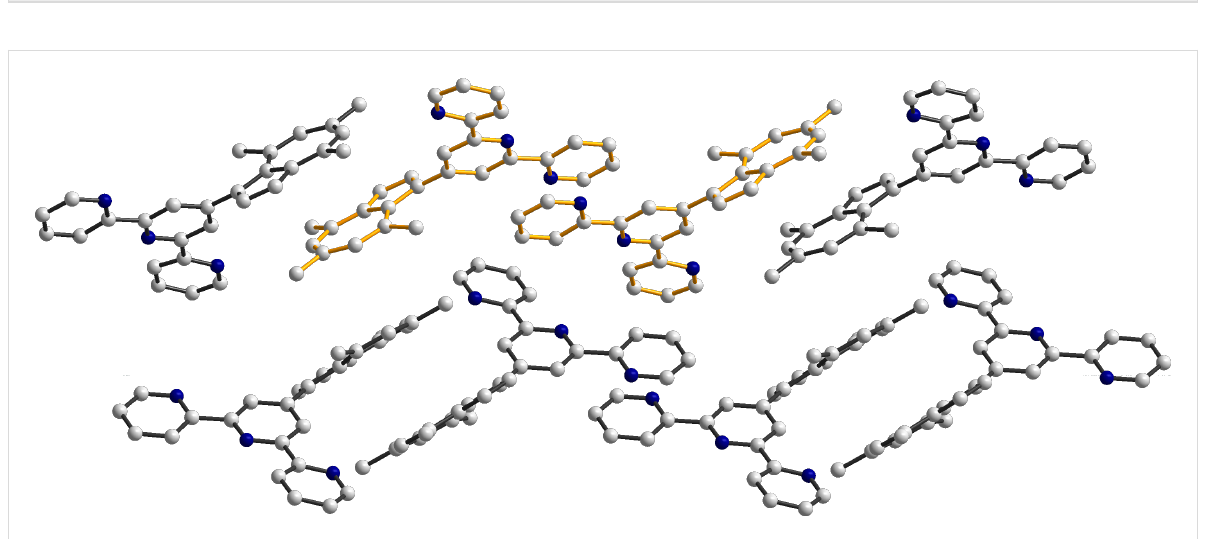
Figure 3: Packing diagram for 4b showing the π – π stacking between the pyridine rings. Hydrogen atoms are omitted for clarity.